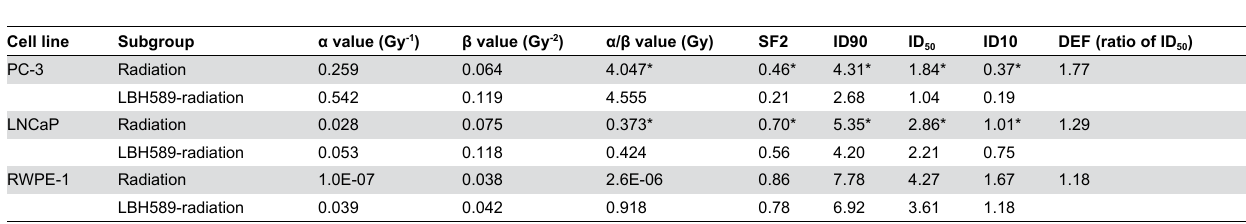
Table 2. Radiobiological parameters for radiation and LBH589-radiation treatment.